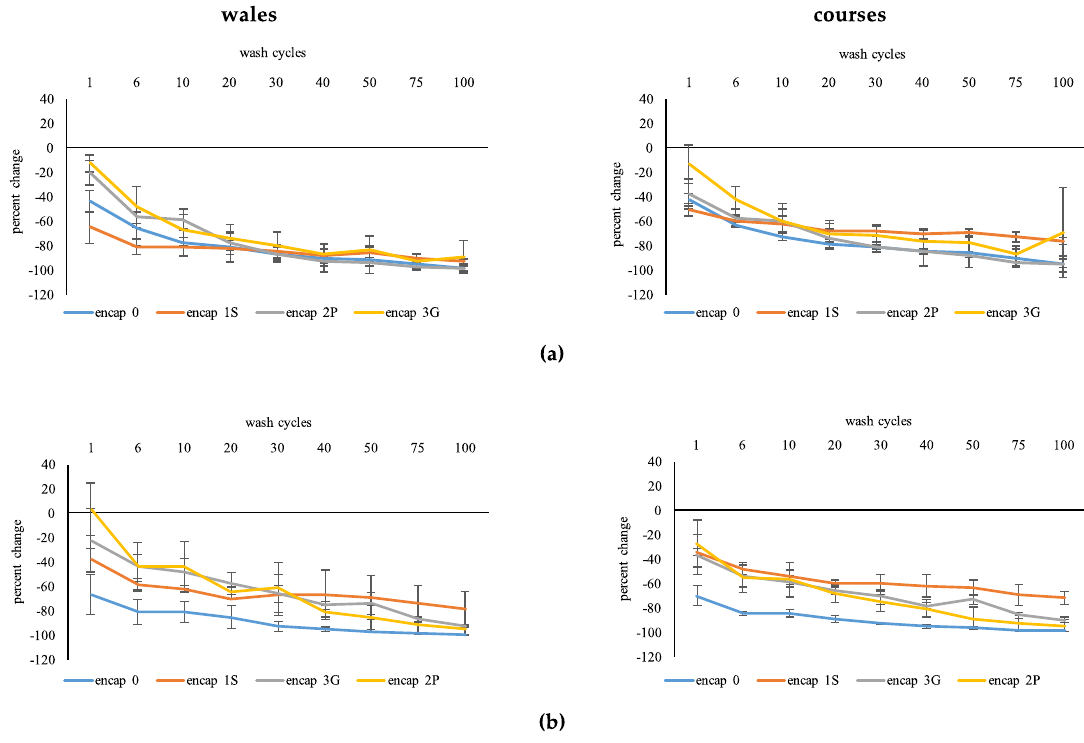
Figure 3. Performance of functionalized fabric with wash. ( a ) Wool. ( b ) Cotton.